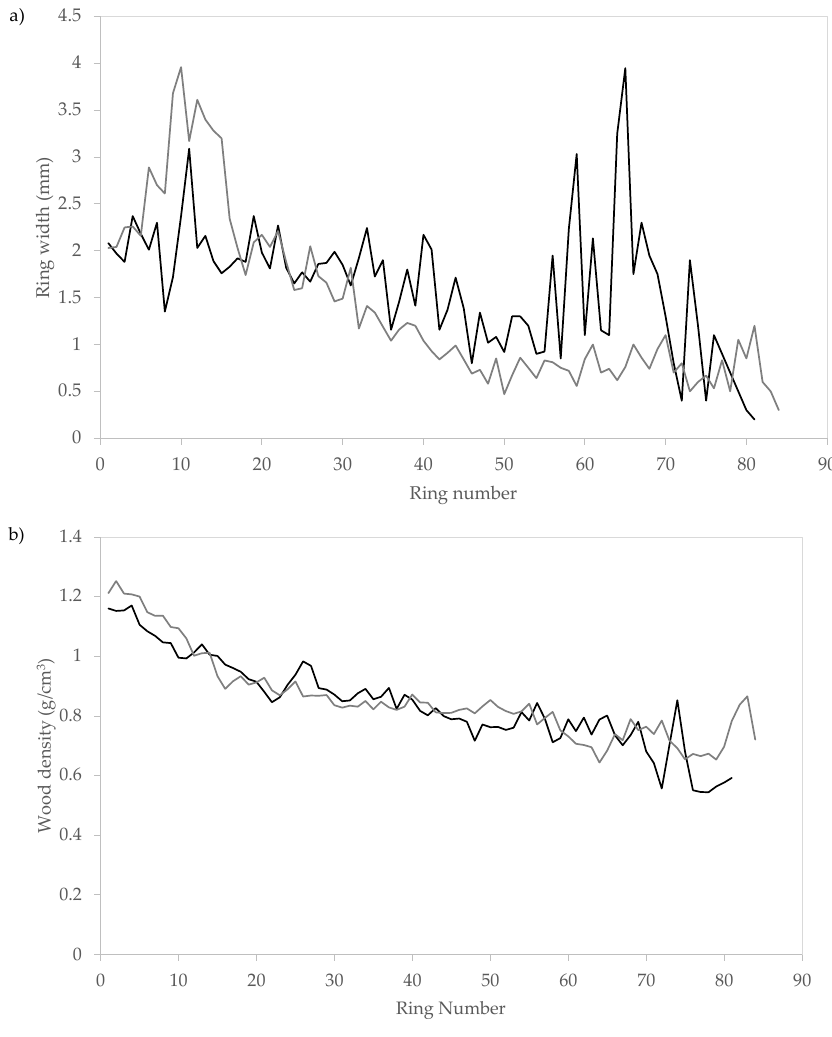
Figure 2. Variation of ( a ) ring width (RW) and ( b ) mean ring density (RD) at b.h. for the studied Quercus rotundifolia trees at site 1 (black line) and site 2 (grey line). Mean for 10 trees till the 31st ring at site 1 and till the 58th at site 2, decreasing afterwards according the cambial age of trees. Reports of ring width or average growth rate (i.e., diameter divided by tree age) in Q. ilex trees showed also wider rings for the first 20 rings compared to later periods, de- creasing from 3.8 mm to 2.1 mm (from the 21st to the 65th ring) [35]. This growth variation was also found in ring-porous oak species such as Q. faginea [25], Quercus garryana Doug- las ex Hook. [62], Q. acutissima , and Q. variabilis [54]. A similar growth trend with irregular and higher growth during the first 15 – 20 years followed by a more continuous growth decrease was found in tropical species, for instance, in Tectona grandis L. (6.1 mm for the first 20 years and 4.0 mm for the period 30 – 45 years) [63]. However, comparisons should be made carefully since species growth depends on genetic, site, and climate conditions as well as on silviculture. The radial decrease of ring width has been also explained by a different growth of earlywood and latewood, namely by a decrease in latewood proportion in some ring-po- rous Quercus species such as Q. acutissima and Q. variabilis [54], Quercus rubra Liebl. [64], Q. petraea and Q. robur [23,31]. In diffuse or semi-ring porous species this explanation does not apply, and other ring structural features may be important. However, some of the year-to-year fluctuations found in Q. rotundifolia could be explained as reported for Q. ilex , i.e., the narrow rings may be a result of the drought summer conditions [14,33,65,66], while the wider rings may be a result of a second or multi growth during the year [35,67,68]. Nevertheless, the ring width variation in Q. ilex was found as less climate-sen- sitive compared, for example, to vessel-related features [44]. It should be noted that the silvicultural operations carried out on the Q. rotundifolia montado stands, e.g., prunings and thinnings, namely related to acorn production may affect tree radial growth and ring width variation [69,70]. A positive response of stem diameter in relation to thinning was obtained in Q. ilex coppices, even if growth remained relatively unchanged at the stand level, and conversion to natural or high forest was sug- gested by the authors [12,71,72]. On the other hand, the effects on reducing water stress are highlighted, and thinnings are considered possible adaptation measures to Mediter- ranean summer droughts [73], which is in line with ecophysiological findings referring Q. ilex and Q. rotundifolia adjustment of water transport capacity in parallel to the foliage area [43]. In fact, crown and radial growth-related traits are also being studied in other oaks,